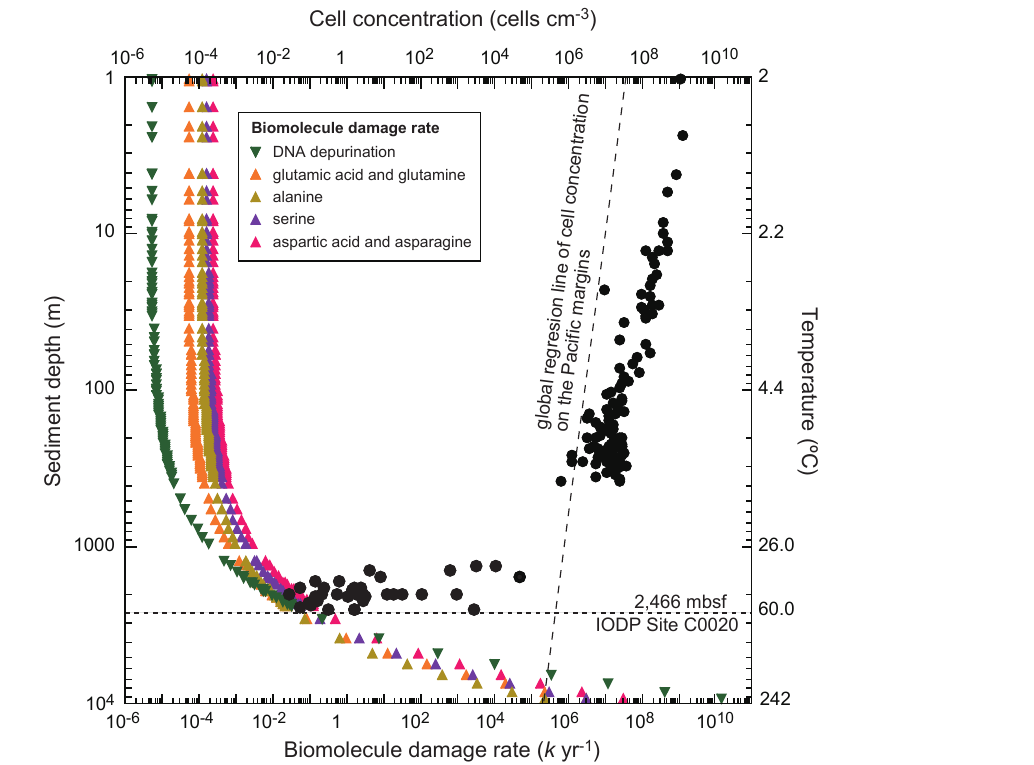
Figure 7. Depth profiles of cell concentrations (black plots), biomolecule damage rates, and in situ temperature at Site C0020. This figure is slightly modified from Fig. S14 in Inagaki et al. (2015), and reprinted with permission from